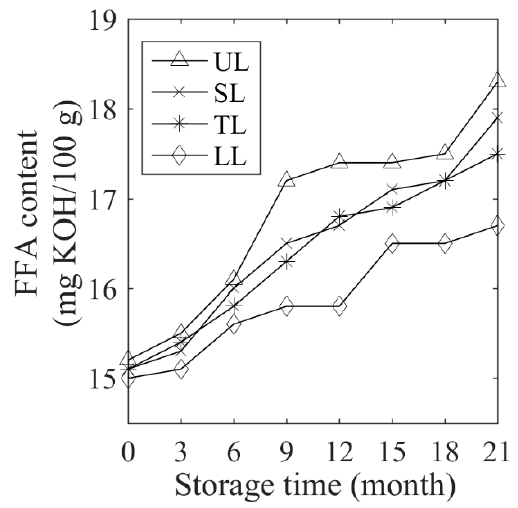
Figure 4. Free fatty acid (FFA) content changes in grain during storage. The value of each point is the average of the 18 positions in the layer.